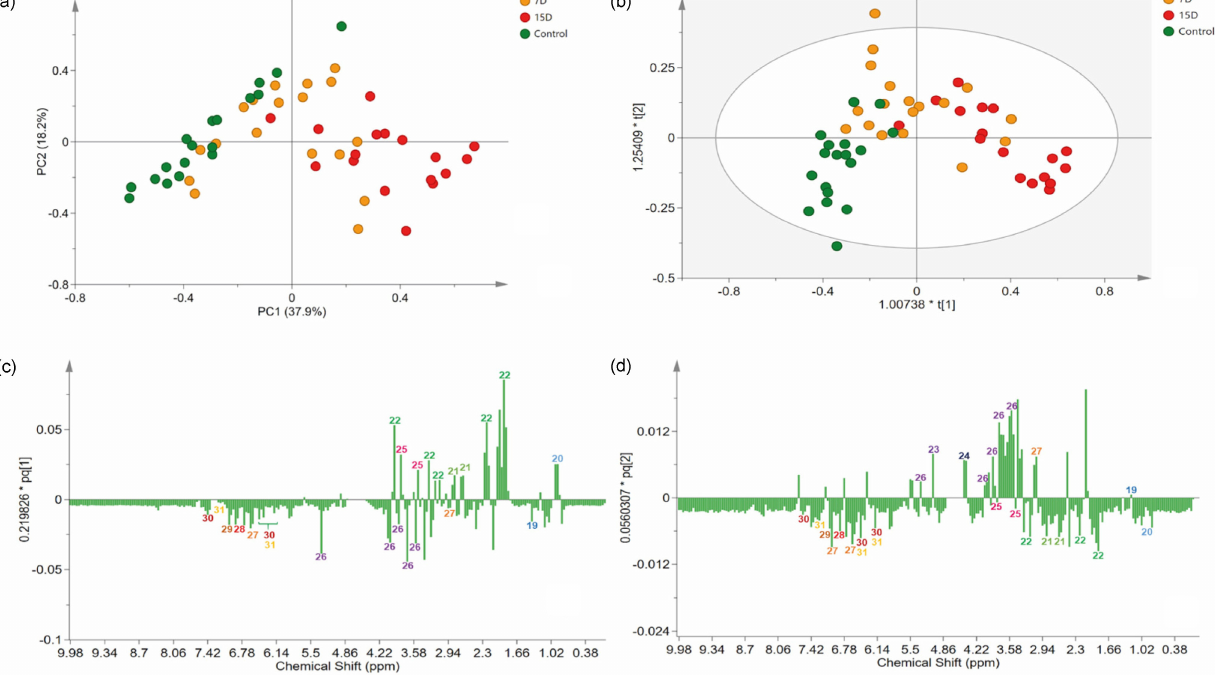
Figure 4. Multivariate analysis of 1 H-NMR data of the hydroalcoholic leaf extract of Bauhinia un- gulata specimens submitted to different water irrigation periods. ( a ) Score scatter plot of principal component analysis (PCA), showing three groups of samples according to water irrigation periods. ( b ) Orthogonal projections of latent structure discriminant analysis (OPLS-DA) score plot. ( c , d ) Load- ings plot from the OPLS-DA, displayed as columns. Numbers in the columns indicate the identified features. The color of the number indicates the class of the compounds according to Classyfire and mapped in the molecular network (see Figure